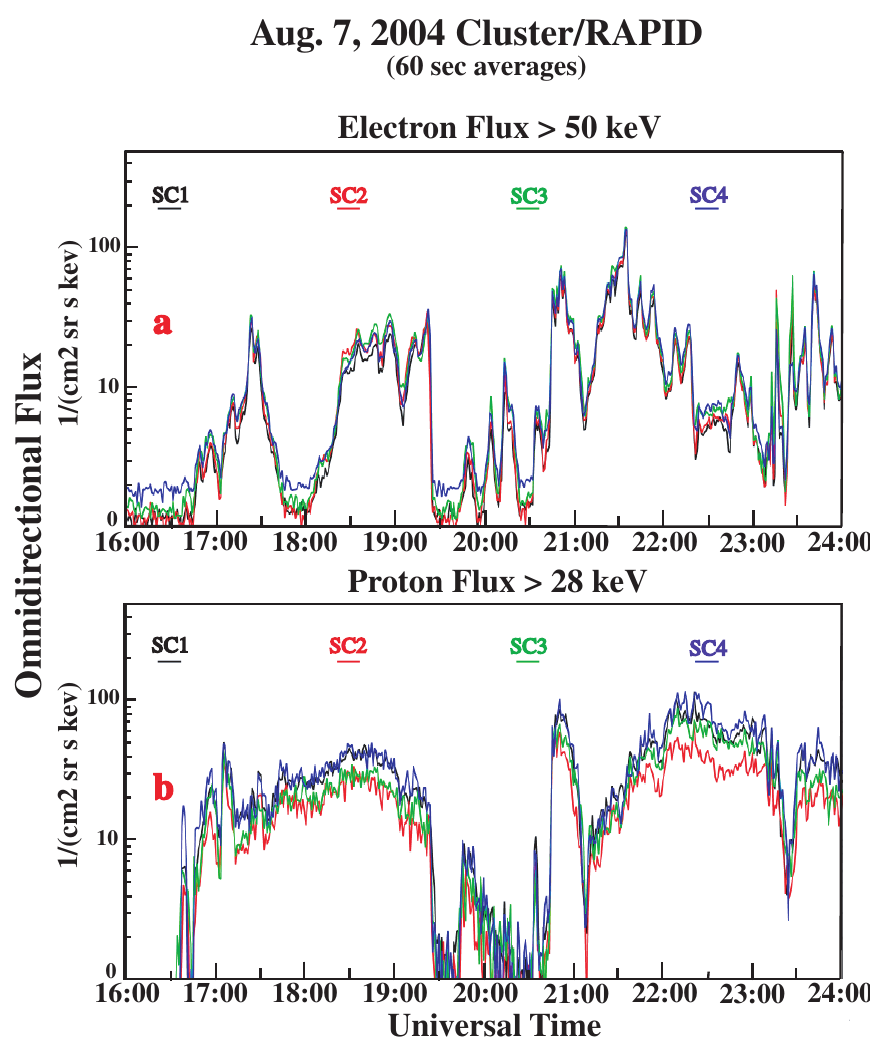
Fig. 4. Energetic electron and proton fluxes observed by RAPID instrument for all four Cluster satellite on 7 August 2004. SC1, SC2, SC3 and SC4 are represented by black, red, green and blue lines,